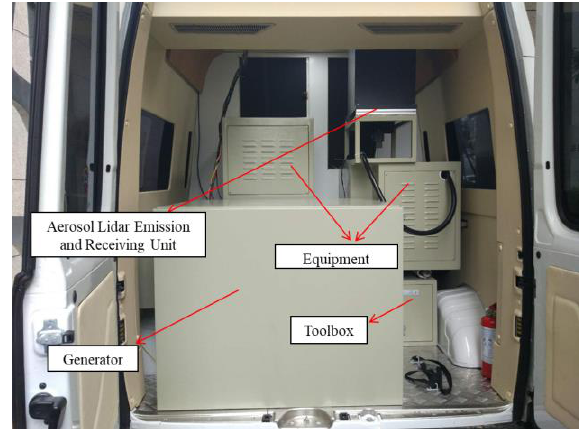
Fig. 1 Structure of mobile lidar